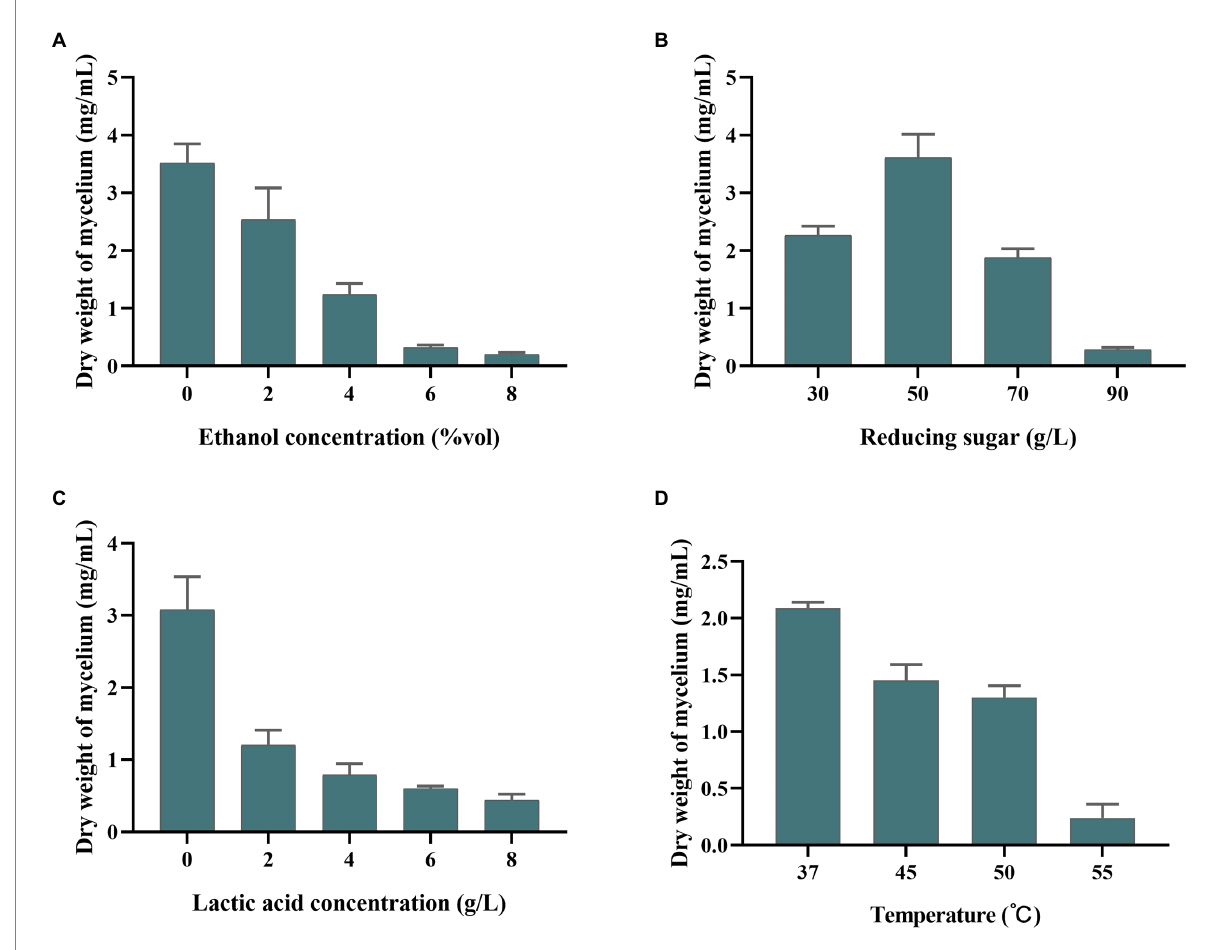
FIGURE 3 Tolerance of S. rosea A22 to different concentrations of ethanol (A) , reducing sugars (B) , lactic acid (C) , and different temperatures (D)